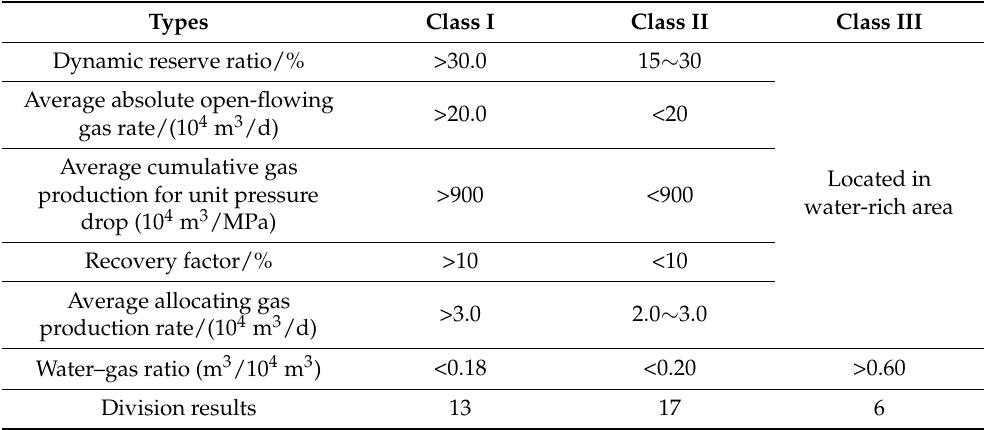
Table 2. Classification criteria and results for developed units in Jingbian gas